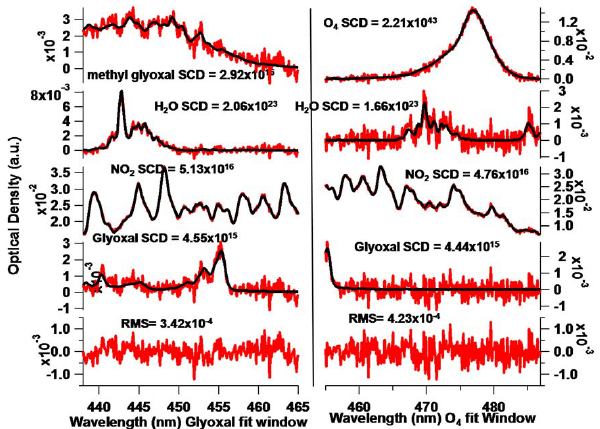
Fig. 10. Example retrievals using LED-CE-DOAS in open cav- ity mode: glyoxal (274 ± 14pptv), NO 2 (2.47 ± 0.07ppbv), methyl glyoxal (1.2 ± 0.2ppbv), water and O 4